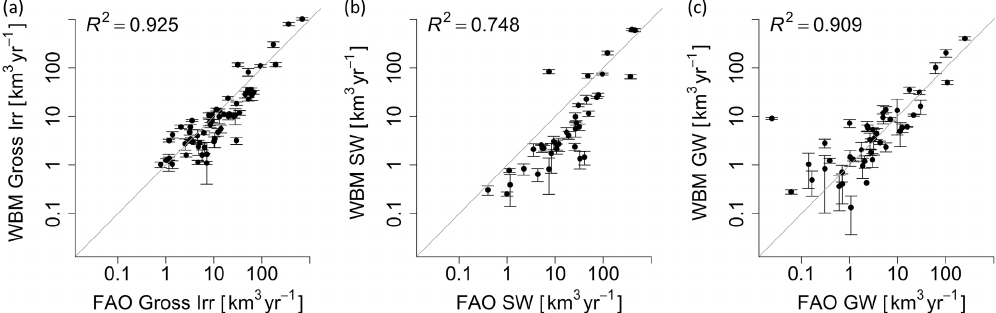
Figure 3. Annual irrigation water withdrawals from WBM compare well to FAO AQUASTAT (FAO, 2016) country-level reported (a) total irrigation, (b) surface water use, and (c) groundwater use. Note that both the x and y axes are on a log scale. Total values from updated simulations (WBM v.1.0.0) are reported in Table 6. Figure modified from Grogan et al.